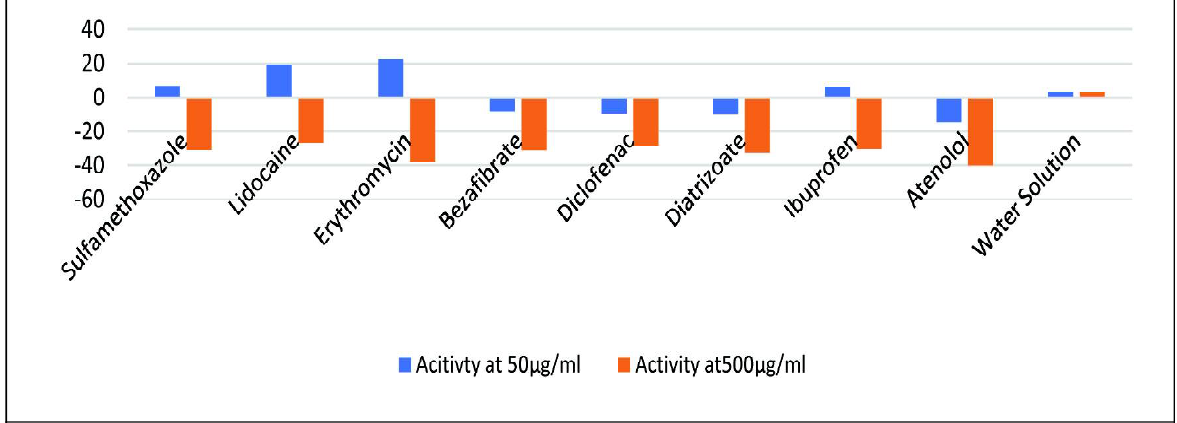
Figure 1: Acute growth stimulation and inhibition of Bacillus subtilis at 50 µ g/ml and 500 µ